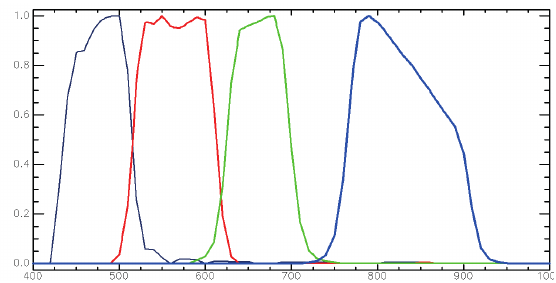
Fig. 1 Spectral response function of HJ-1A